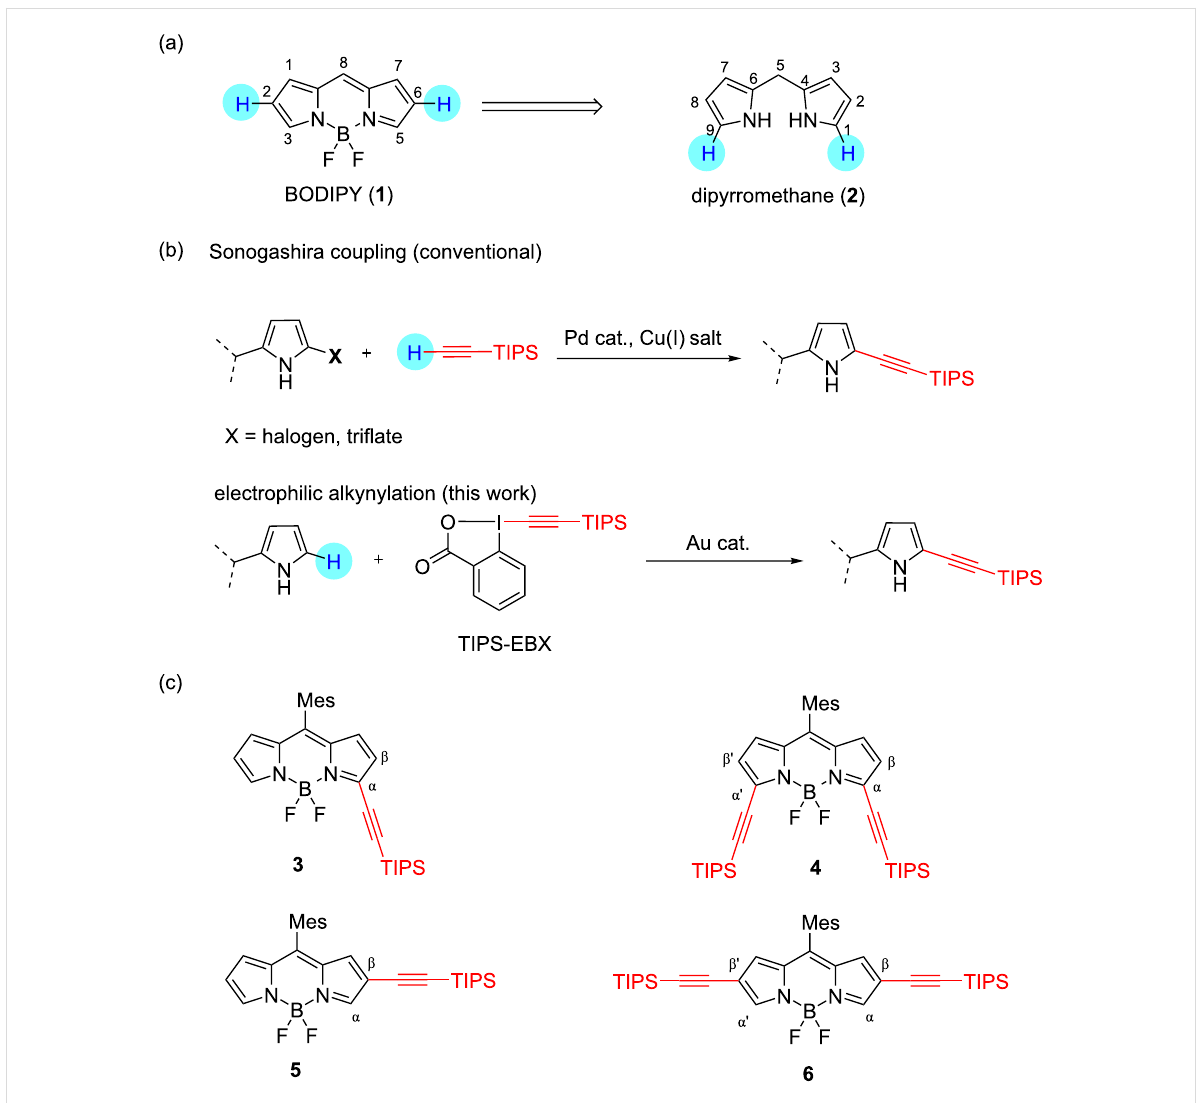
Figure 1: (a) Chemical structures of BODIPY ( 1 ) and dipyrromethane ( 2 ). (b) C–C bond forming alkynylations of pyrrole and its derivatives by Sono- gashira coupling and electrophilic alkynylation. (c) Peripheral alkynylated BODIPY derivatives ( 3–6 ) prepared in this work. TIPS: triisopropylsilyl group; Mes: 2,4,6-trimethylphenyl